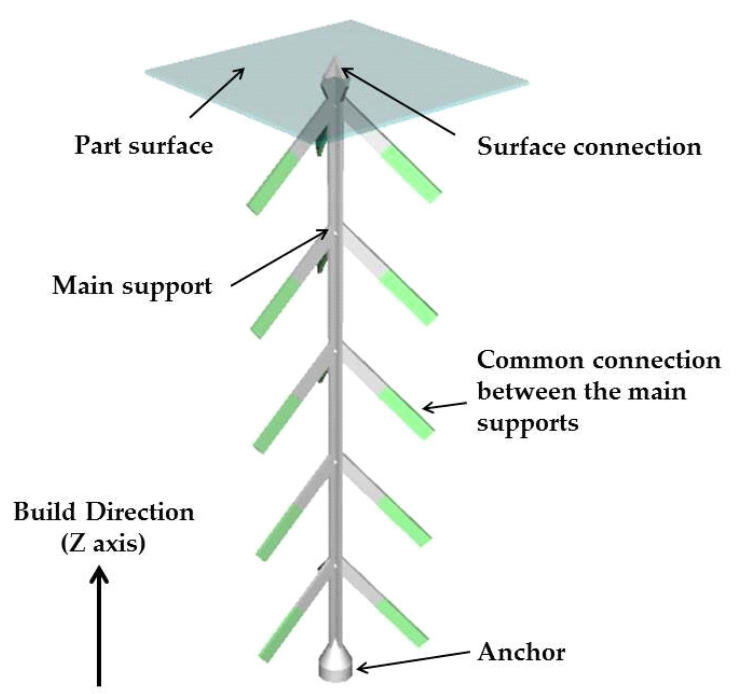
Figure 2. Geometry of the support structures.